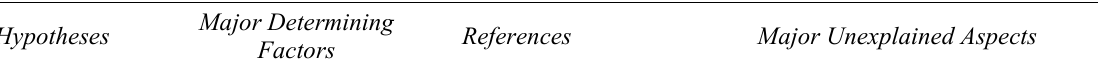
Table 1: Summary of four competing hypotheses regarding the mechanism for arsenic occurrence and mobilization in groundwater in